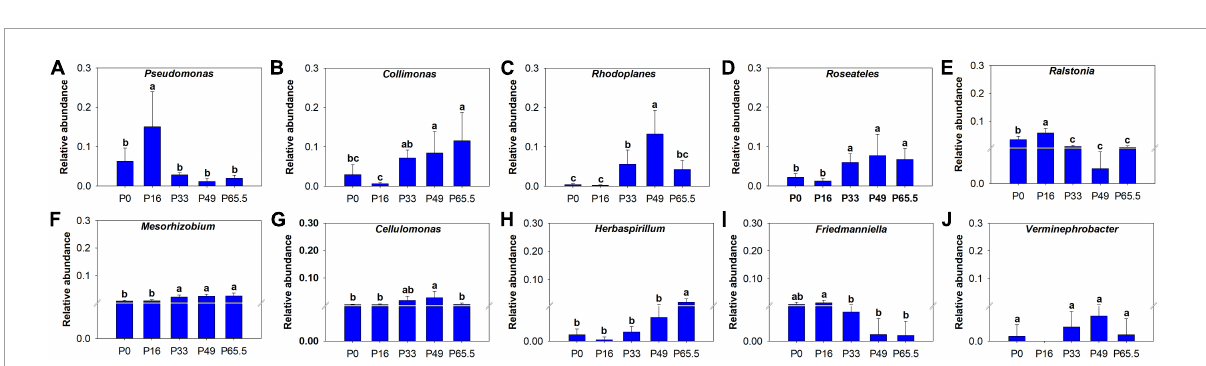
FIGURE5 Bar chart of relative abundance of the keystone taxa at genus level under different phosphorus fertilization rates. (A) Pseudomonas ; (B) Collimonas ; (C) Rhodoplanes ; (D) Roseateles ; (E) Ralstonia ; (F) Mesorhizobium ; (G) Cellulomonas ; (H) Herbaspirillum ; (I) Friedmanniella ; (J) Verminephrobacter . The key species were selected by ranking the top 10 “Degree” values based on the network. P0, P16, P33, P49, and P65.5 represent 0, 16, 33, 49, and 65.5 kg P ha − 1 ,